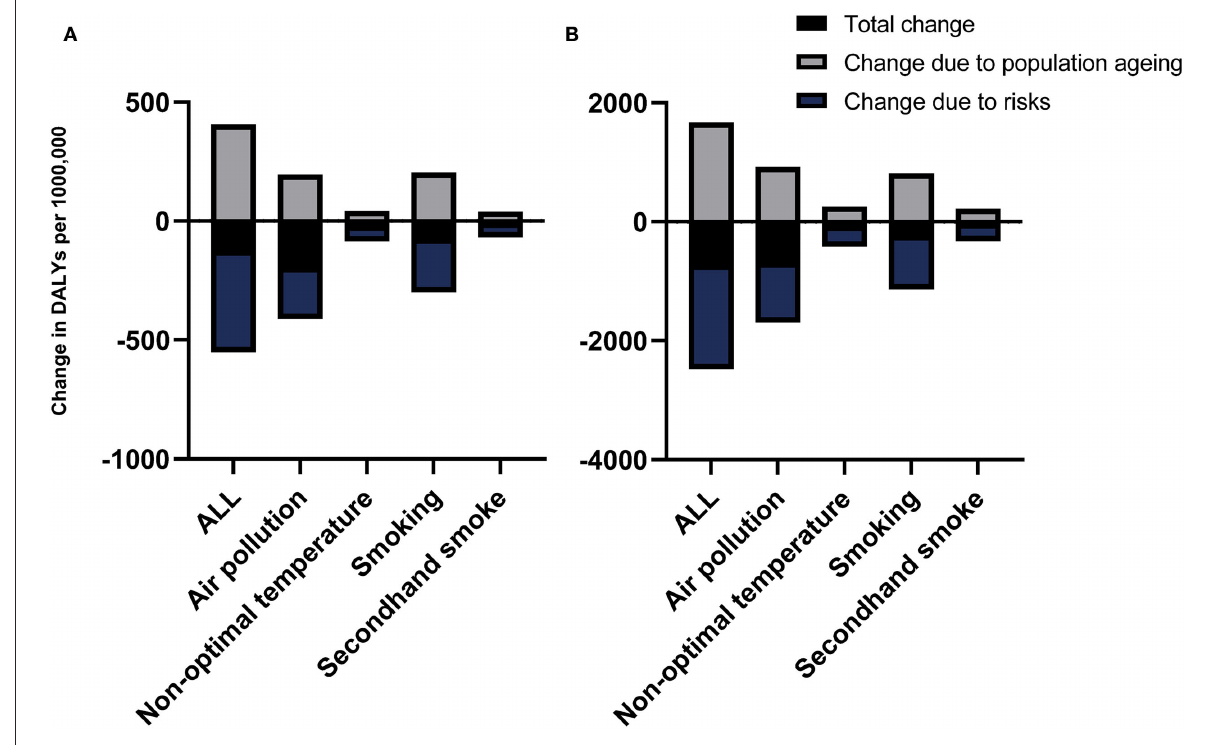
FIGURE3 The change in ASR of COPD DALY considering the population aging in different risk factors in the world (A) and China (B)